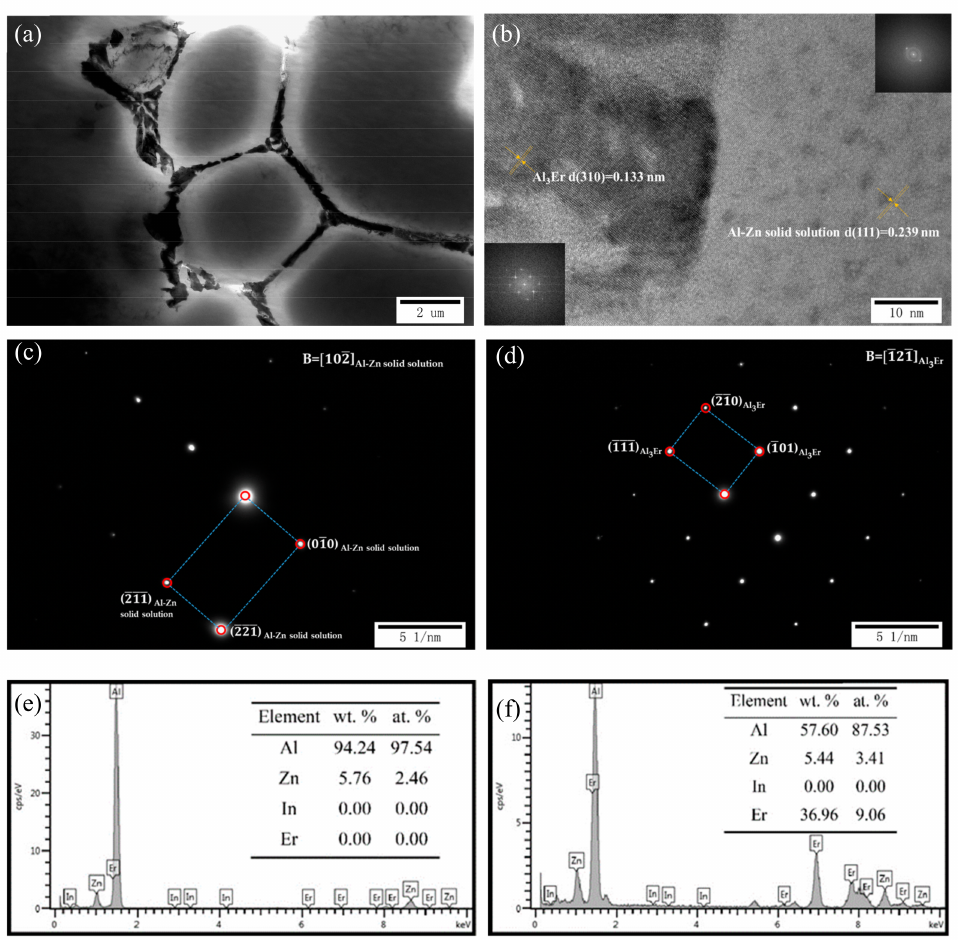
Figure 5. TEM images of the as-cast Al–5Zn–0.03In–1Er alloy: ( a ) TEM image, ( b ) HRTEM, ( c ) the SAEDP of the alloy matrix, ( d ) the SAEDP of the second phase, ( e ) the EDS of the alloy matrix, ( f ) the EDS of the second